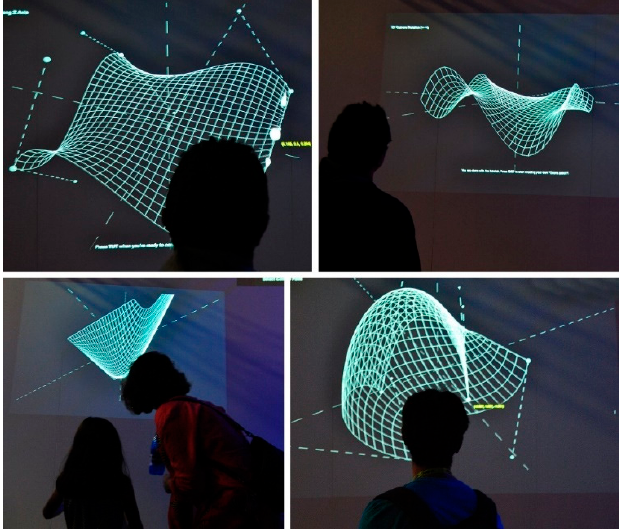
Figure 8. “Coons Patch” reconstruction by Daniel Cardoso-Llach. Used by permission of Daniel Figure 8. “ Coons Patch ” reconstruction by Daniel Cardoso-Llach. Used by permission of Daniel Cardoso-Llach. Photographs by Daniel Cardoso-Llach. Cardoso-Llach. Photographs by Daniel